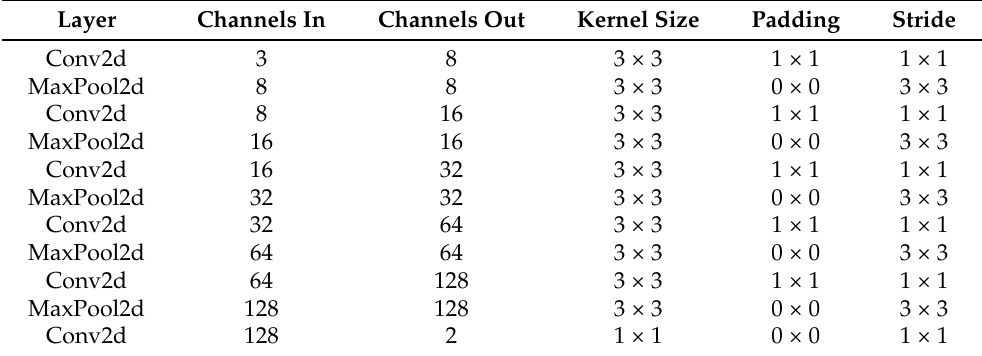
Table 1. Architecture of the deep convolutional neural network. Layer Channels In Channels Out Kernel Size Padding Stride Conv2d 3 8 3 × 3 1 × 1 1 × 1 MaxPool2d 8 8 3 × 3 0 × 0 3 × 3 Conv2d 8 16 3 × 3 1 × 1 1 × 1 MaxPool2d 16 16 3 × 3 0 × 0 3 × 3 Conv2d 16 32 3 × 3 1 × 1 1 × 1 MaxPool2d 32 32 3 × 3 0 × 0 3 × 3 Conv2d 32 64 3 × 3 1 × 1 1 × 1 MaxPool2d 64 64 3 × 3 0 × 0 3 × 3 Conv2d 64 128 3 × 3 1 × 1 1 × 1 MaxPool2d 128 128 3 × 3 0 × 0 3 × 3 Conv2d 128 2 1 × 1 0 × 0 1 ×